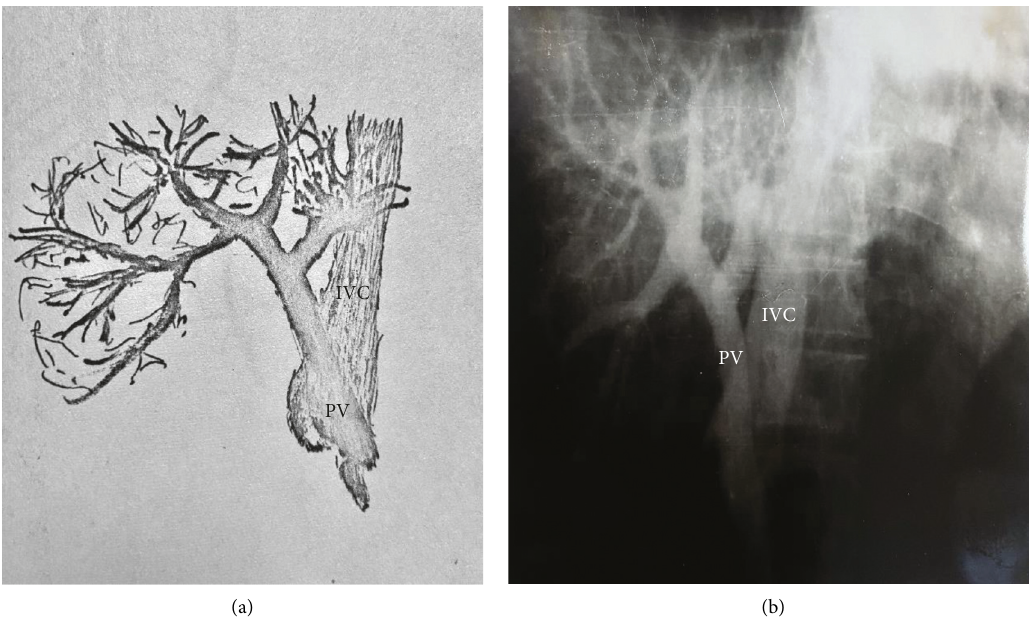
Figure 2: (a) and (b) PHT (portal hypertension) stage III A Ileoportography (IPG) after latero-lateral portocaval anastomosis. Functional anastomosis. Opacification of the inferior vena cava (IVC). Uninjected left hepatic lobe. Hepatoportal flow is present together with a discreet retro-hepatic narrowing of the vena cava. PV—portal vein. ( E. Br˘atucu — Private collection)